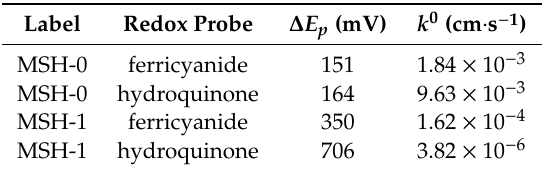
Table 4. Peak separation ( ∆ E p ) and transfer kinetic constant ( k 0 ) for ferricyanide and hydroquinone probes on MSH-0 and MSH-1